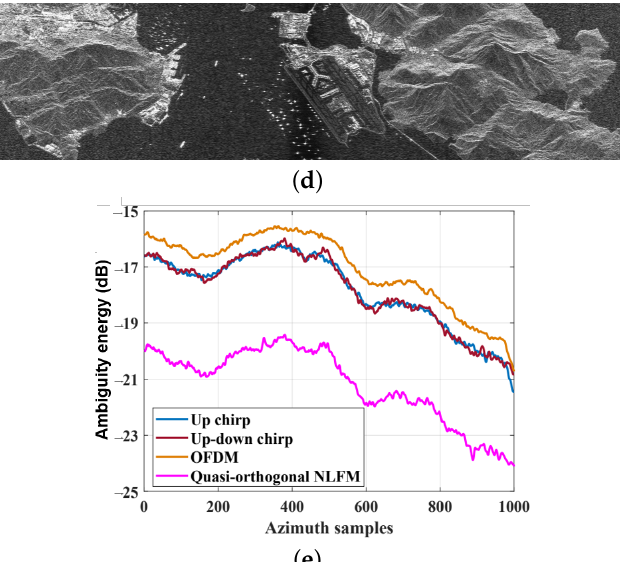
Figure 11. Azimuth ambiguity suppression for the HV polarization of hybrid quad-pol mode. Imag- ing results for ( a ) up chirp waveforms, ( b ) up-down chirp waveforms, ( c ) OFDM chirp waveforms, ( d ) quasi-orthogonal NLFM waveform. ( e ) Azimuth profiles of the ambiguity energy.